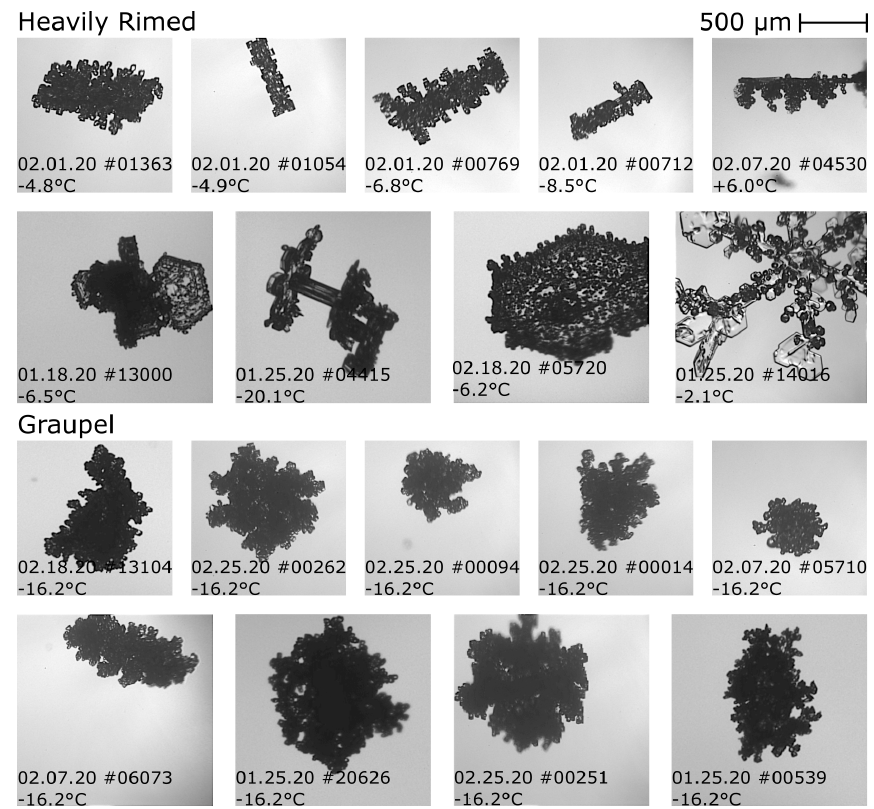
Figure 3. Examples of representative PHIPS particles with different degrees of riming depending on the surface riming degree (SRD): heavily rimed (50% < SRD < 100%) and graupel particles (SRD = 100%). Unrimed (SRD = 0%), slightly rimed (0% < SRD < 25%) and moderately rimed particles (25 ≤ SRD ≤ 50%) are shown in Fig.